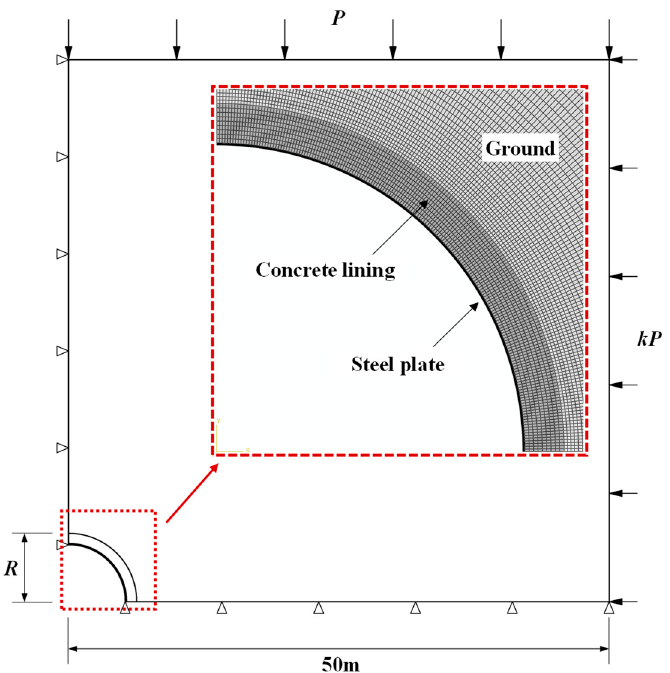
Figure 7. Finite element mesh for circular tunnel strengthened by steel plate. Table 1. Parameters of each material in the proposed model.